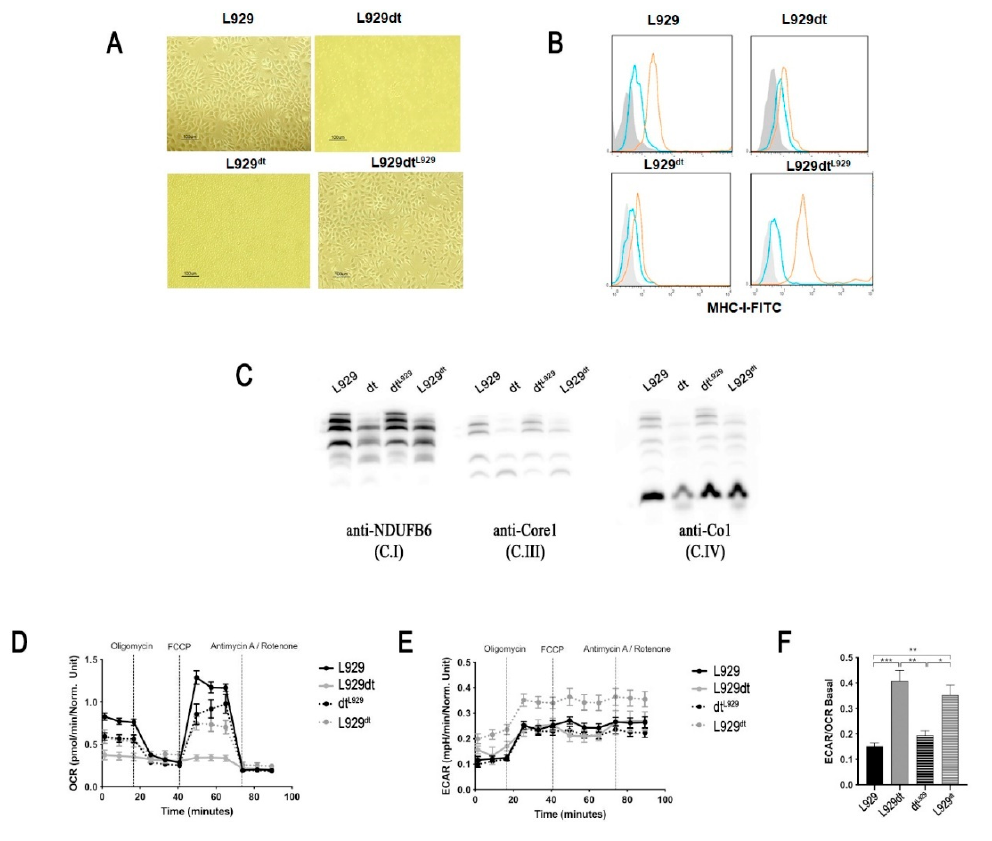
Figure 7. Properties of cybrid cells. L929 dt cybrid cells contain L929dt mitochondria on a L929 nuclear background and L929dt L929 cells contain L929 mitochondria on an L929dt nuclear background. ( A ) Phase contrast micrographs of cultures of L929, L929dt, or cybrid cells. ( B ) MHC-I expression on the surface of the indicated cells, determined by flow cytometry using a specific anti-H-2K k antibody conjugated with FITC. Grey histograms, labeling of the cells alone; blue histograms, labeling with an irrelevant antibody of the same isotype and conjugated with FITC; orange histograms, labeling with the anti-H2-K k mAb conjugated with FITC. ( C ) Supercomplex formation involving complex I, complex III or complex IV in the different cell types, determined by immunoblot in the same way as indicated in the legend of Figure 3. The amount of complex II in the same samples was used as loading control. ( D ) Oxygen consumption rate (OCR) and ( E ) extracellular acidification rate (ECAR) measurement upon sequential addition of oligomycin, FCCP, and rotenone + antimycin A in L929 (black dots and solid black lines), L929dt (grey dots and solid grey lines), L929 dt (grey dots and dashed lines) and dt L929 (black dots and dashed lines) cells using the Seahorse XF96 Extracellular Flux Analyzer. ( F ) ECAR to OCR ratio at basal respiration in the four cell lines, as indicated. Data are expressed as in Figure 2. *, p < 0.05; **, p < 0.01; ***, p < 0.001.